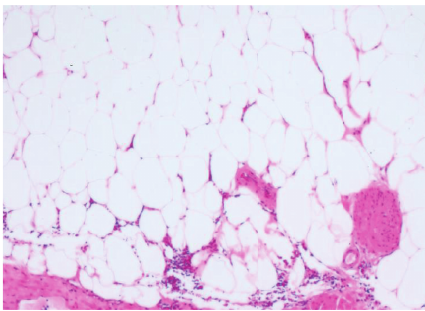
Figure 3: Histopathologically, retroperitoneal lipoma consists entirely of mature